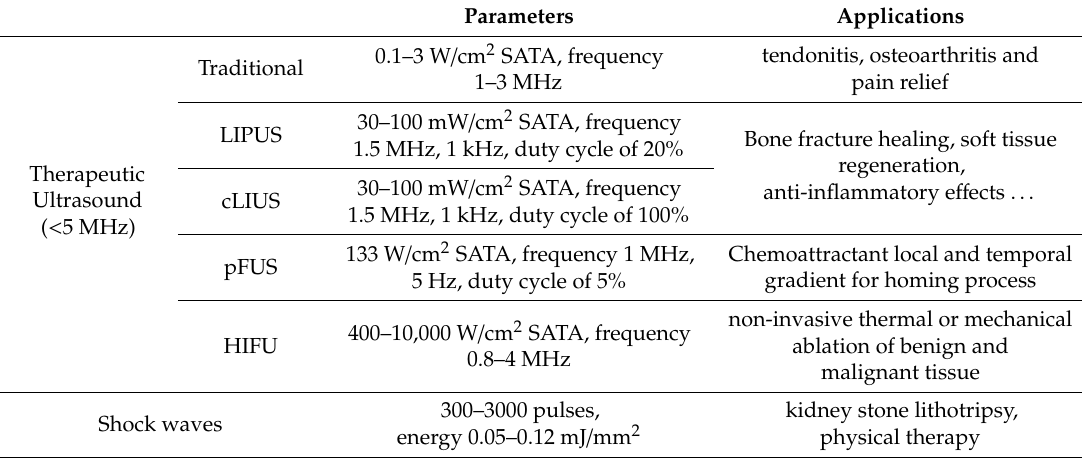
Table 1. Methodologies of therapeutic ultrasound and shock wave